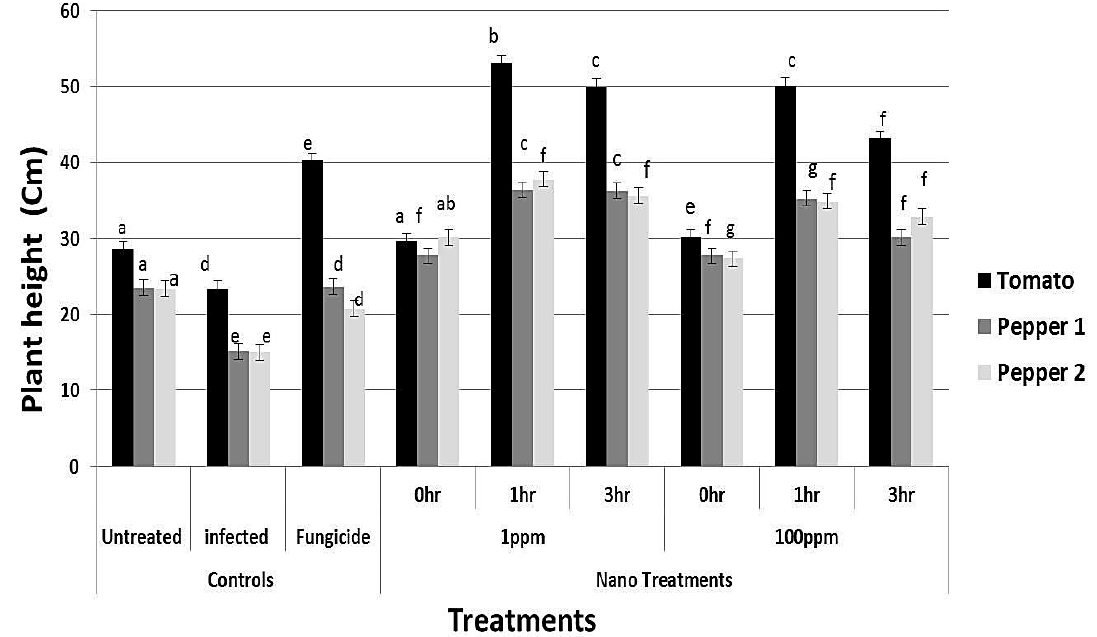
Figure 10. Effect of rGO-CuO NP treatments, as indicated, on plant height of tomato and pepper plants (nine biological replicates). Two independent experiments with pepper plants are plotted. Letters on bars mean statistically significant differences between the mean of the respective control and the nanocomposite at the same concentration ( p ˂ 0.05).